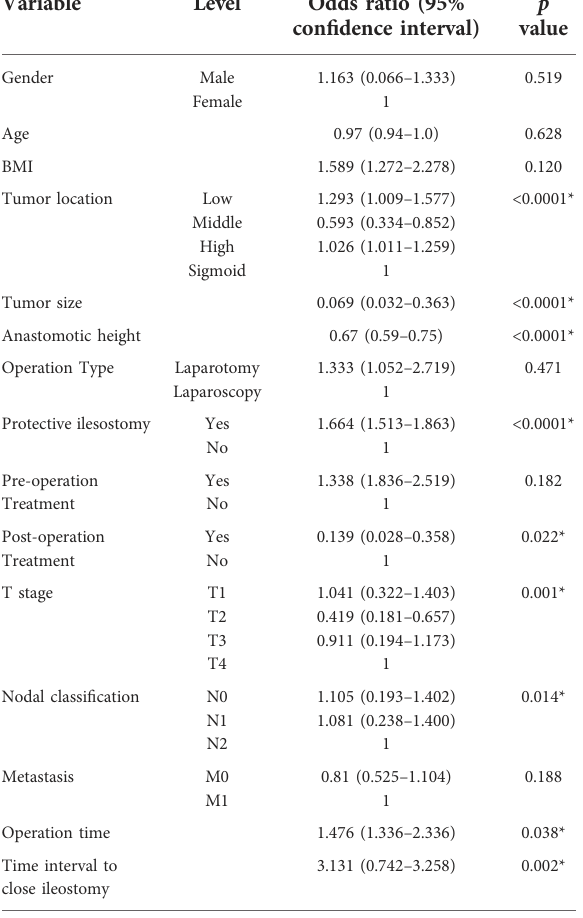
TABLE 3 Result of univariate